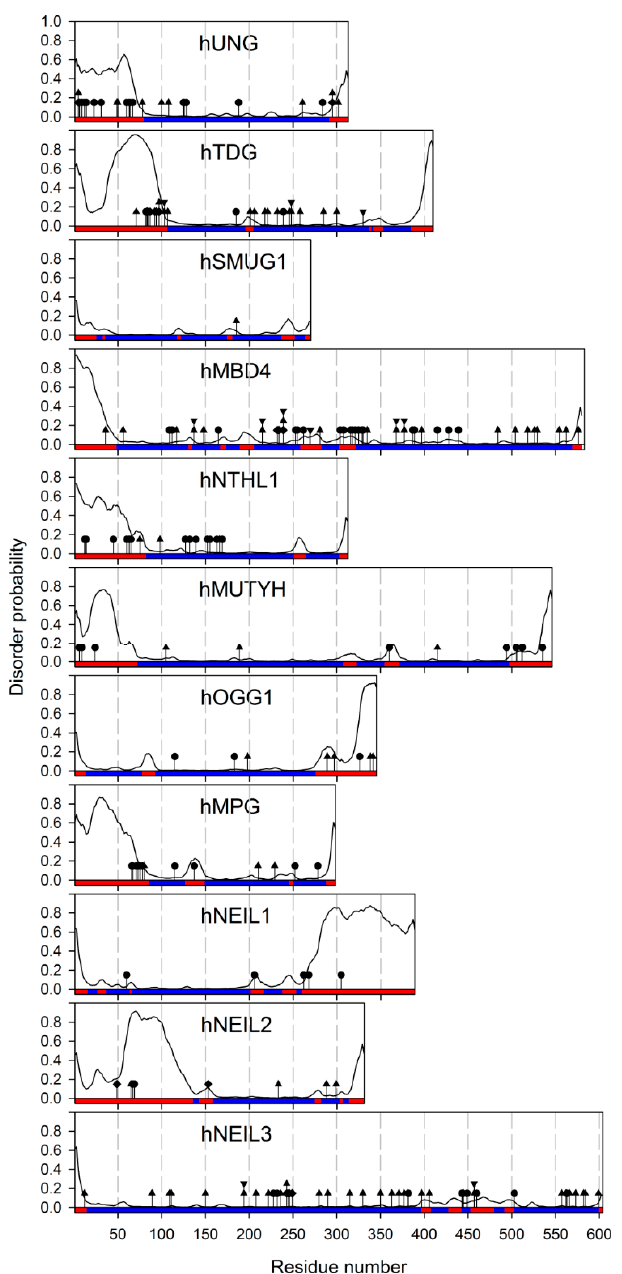
Figure 2. Predicted disorder and sites of post-translational modifications in human DNA glycosylases. The disorder probabilities were calculated using the ESpritz neural network [12]. The colored bar corresponds to ESpritz predictions: ordered (blue) and disordered (red). The sites of post-translational modifications are labeled by circles (Ser/Thr/Tyr phosphorylation), diamonds (Lys acetylation), triangles (Lys ubiquitylation), and reverse triangles (Lys sumoylation). The sites of modifications are taken from the PhosphoSitePlus proteomic database [13] and low-throughput studies discussed in the main